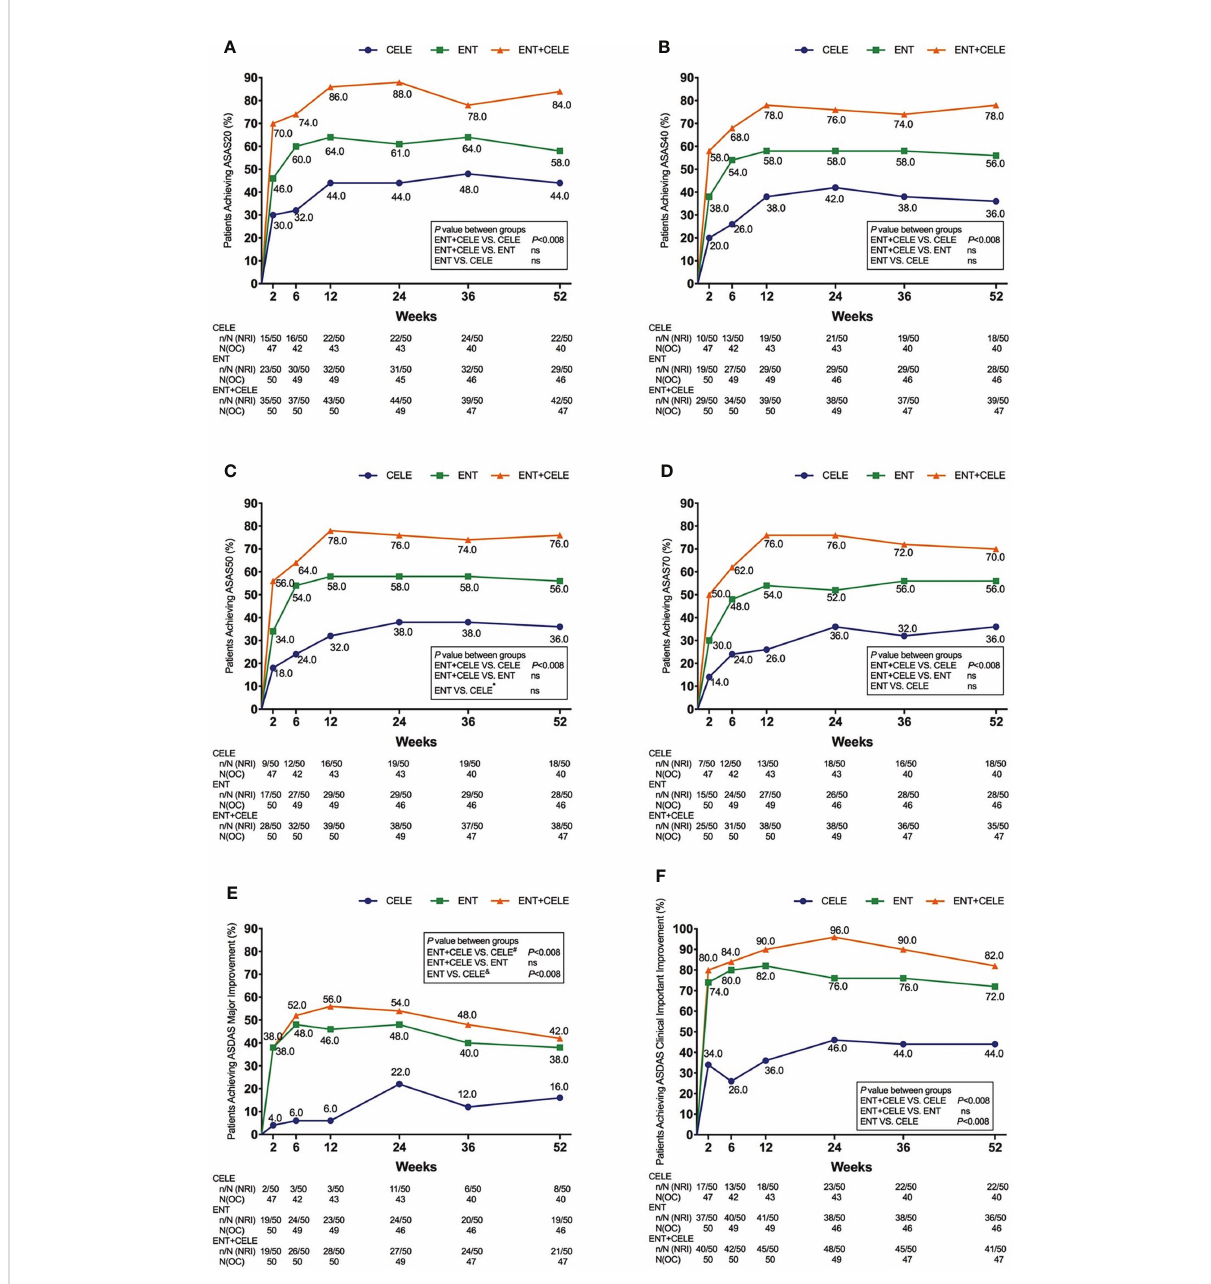
FIGURE 3 Proportion of patients achieving (A) ASAS20 response, (B) ASAS40 response, (C) ASAS50 response, (D) ASAS70 response, (E) ASDAS major improvement, and (F) ASDAS clinical important improvement in the three groups over 52 weeks. Population is modi fi ed intention to treat, non- responder imputation (NRI). The actual number of patients is shown as the observed case (OC). P -values for differences in the results between groups at any timepoint are from the Kruskal – Wallis test, and the adjusted P -value for signi fi cance is 0.008 in multiple comparisons between groups. ASAS, Assessment of SpondyloArthritis International Society; ASDAS, Ankylosing Spondylitis Disease Activity Score; ENT, etanercept; CELE, celecoxib; ns, non-signi fi cant. *, signi fi cant difference was found between the etanercept and celecoxib groups only at week 2. # , no signi fi cant difference was found between the etanercept + celecoxib and celecoxib groups at week 52. & , signi fi cant differences were found between etanercept and celecoxib groups at weeks 2, 6, 12, and